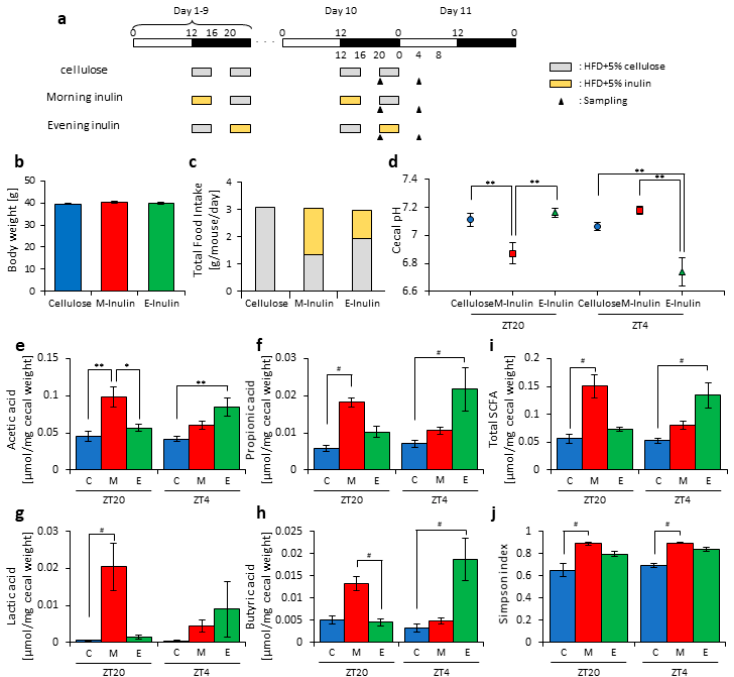
Figure 3. Morning inulin feeding decreased cecal pH and increased short-chain-fatty-acids more than evening inulin feeding. ( a ) Experimental schedule, where white and black bars indicate environmental 12 h light and dark conditions, respectively. The gray bar indicates feeding with a high-fat-diet (HFD) and 5% cellulose. The yellow bar indicates feeding with HFD and 5% inulin. The black arrowhead indicates the sampling time. ( b ) Body weight before sampling. ( c ) Average daily food intake. The gray bar indicates the average daily food intake of cellulose, and the yellow bar indicates the average daily food intake of inulin. ( d ) Cecal pH of mice housed for 10 days for each group. ( e – i ) SCFAs of mice, including ( e ) acetic acid, ( f ) propionic acid, ( g ) lactic acid, ( h ) butyric acid, and ( i ) total SCFAs. ( j ) Bacterial alpha diversity. Comparison of the Simpson index estimation of the 16S rDNA gene libraries at 97% similarity from the sequencing analysis. All values except ( c ) are represented as mean ± SEM (cellulose at ZT20 (n = 5) and 4 (n = 5); morning inulin at ZT20 (n = 5) and 4 (n = 5); evening inulin at ZT20 (n = 5) and 4 (n = 5)). ** p < 0.01, * p < 0.05, evaluated using the two-way ANOVA with Tukey’s post hoc test. # p < 0.05, evaluated using the Kruskal–Wallis test with Dunn post hoc test with a two-stage linear step-up procedure of the Benjamini, Krieger, and Yekutieli